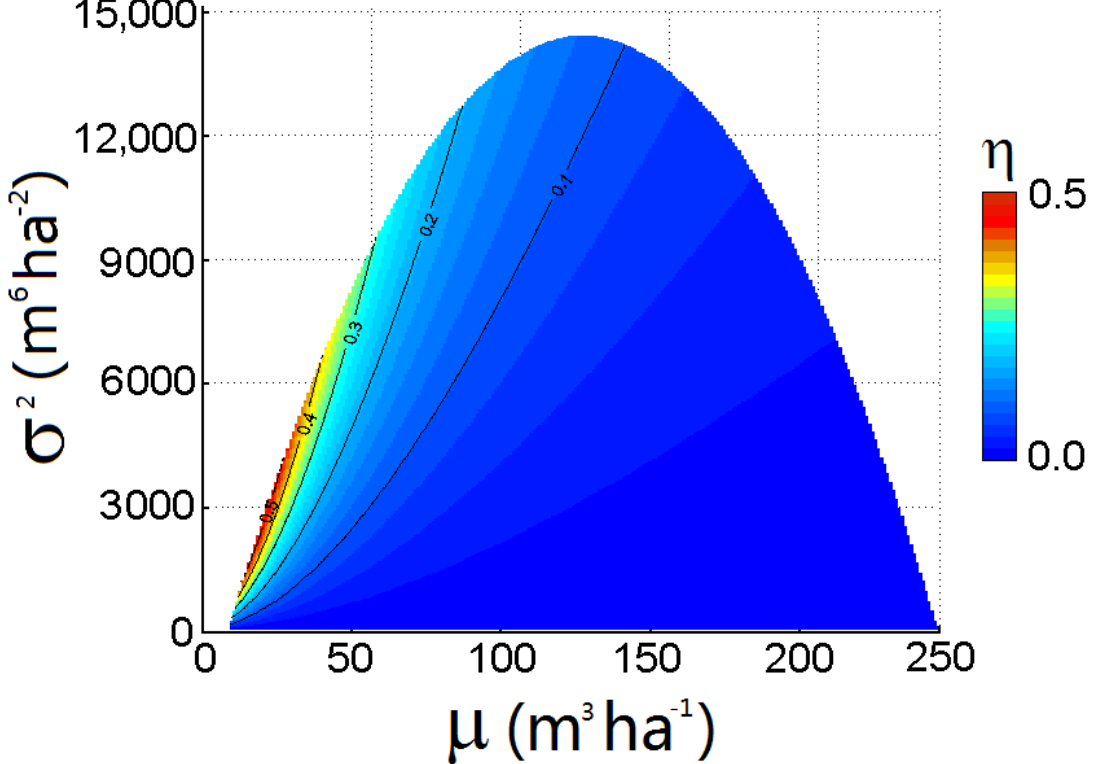
Figure 1. The percentage of scaling error compensated for Pinus yunnanensis Franch. η is the error compensation percentage given by Equation (7), in which this example uses parameters r = 2.7468, k = 0.7623 and, u = 0.000536. µ is the weighted mean of x i (stand stocking volume), and is also the mean regional volume. It is assumed to range from x min (10 m 3 ha − 1 ) to x max (250 m 3 ha − 1 ). σ 2 is the variance of x i .